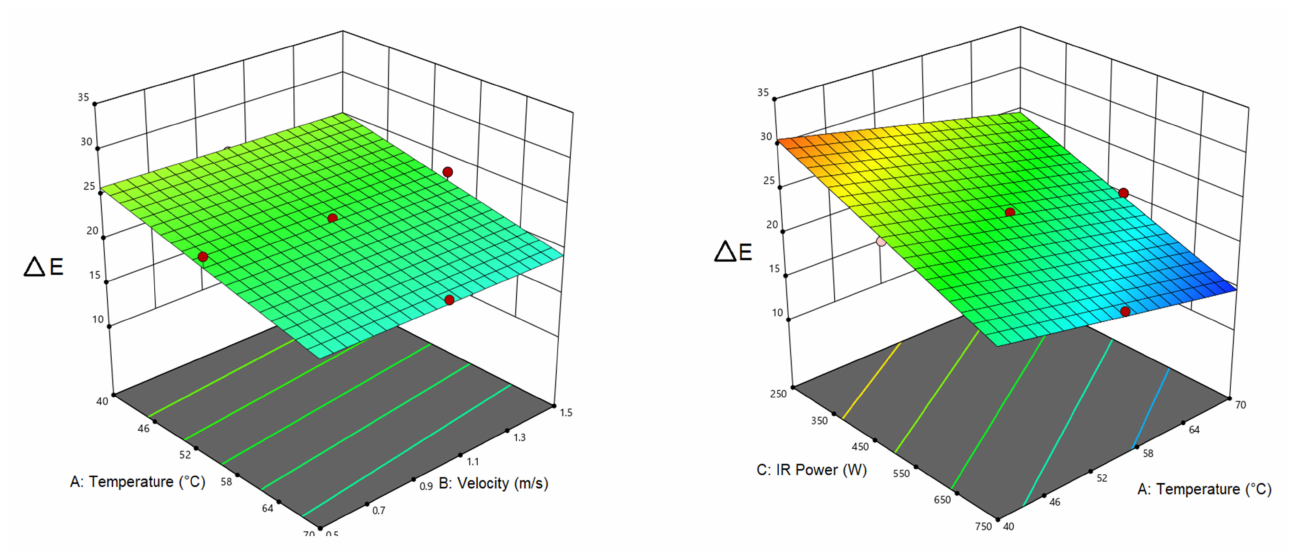
Figure 3. Interaction of air temperature/air velocity and air temperature/IR power on color of pumpkin.